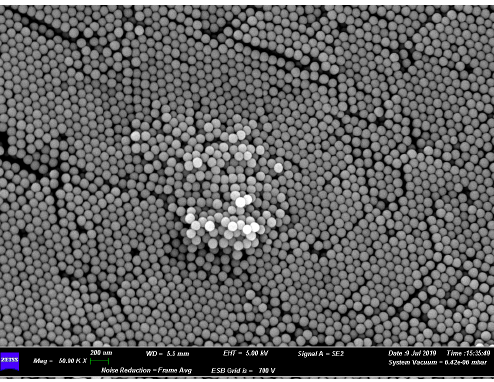
Figure 6. Scanning electron microscopy (SEM): morphological analysis of polystyrene nanoparticles (PNPs) with scanning electron